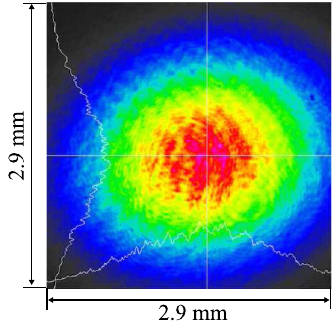
FIG. 16. Laser beam profile measured at behind M2. A regular fringe structure is due to neutral density filters for the laser beam profiler.